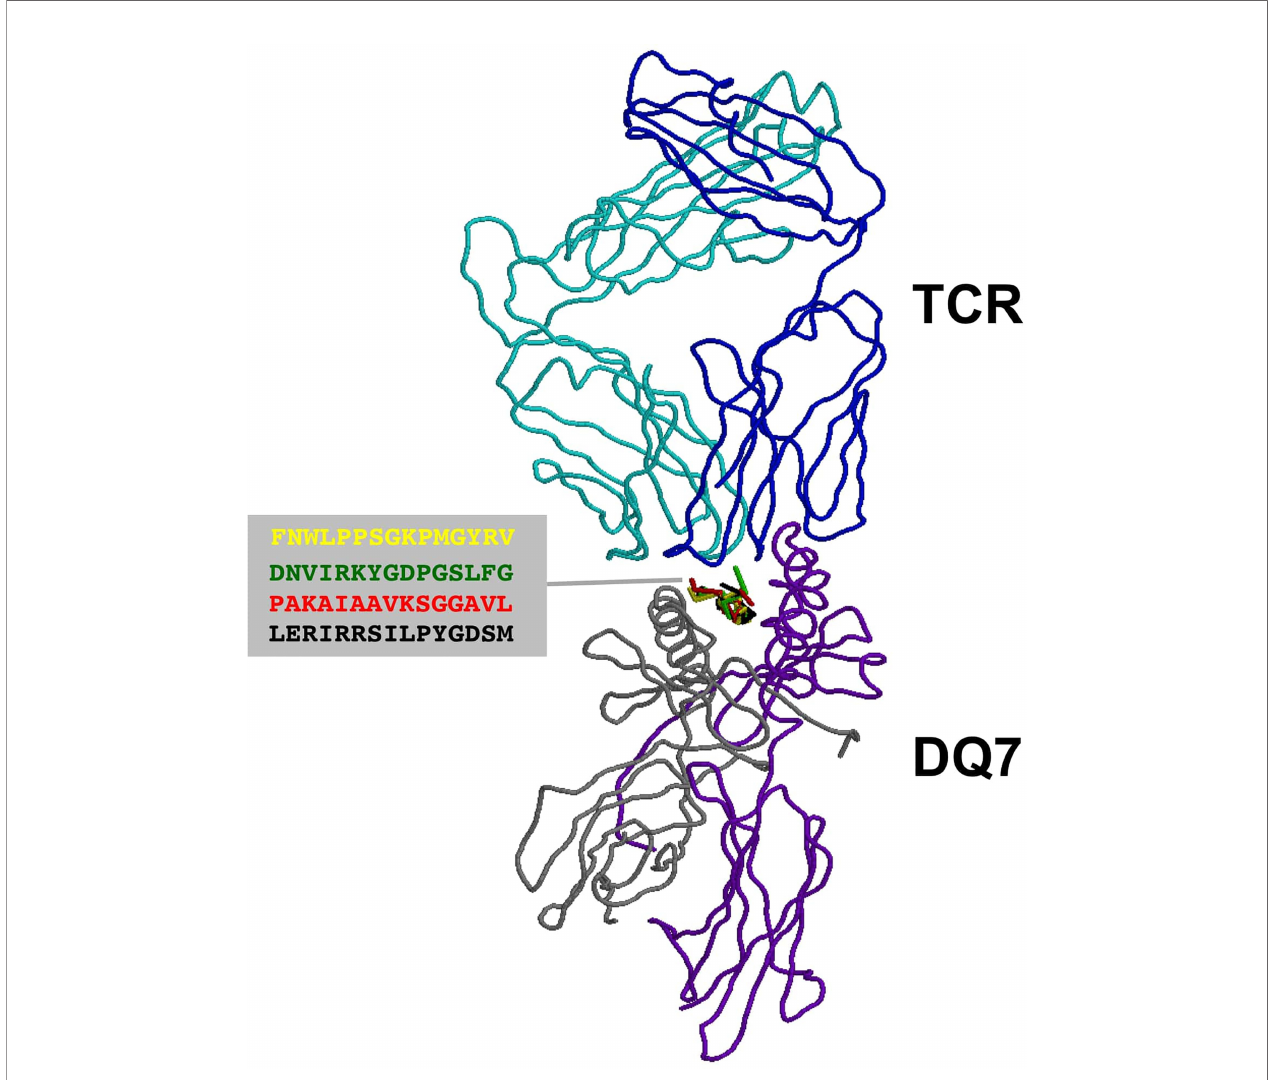
FIGURE 3 | TCR recognition of autoantigens presented by DQ7. Figure shows a ribbon rendering of DQ7 with bound superimposed BP peptide antigens, being recognized by a TCR. BP peptide antigens are colored in yellow (FNWLPPGKPMGYRV), green (DNVIRKYGDPGSLFG), red (PAKAIAAVKSGGAVL) and black (LERIRRSILPYGDSM), respectively. DQ7 a and b chains are colored in purple and grey, respectively, while the a and b chains of the TCR are shown in cyan and blue, respectively. The TCR was positioned after superimposing the tertiary structure of DQ7 models with that in PDB 5KS9 corresponding to HLA-DQ8 with a bound glia- a 1 peptide in complex with a TCR. Tertiary structures of peptide-DQ7 complexes were obtained by homology modeling (details in Methods ) and superimposition of tertiary structures and molecular graphic representations were obtained using PyMol Molecular Graphics System, Version 2.0 Schrödinger,